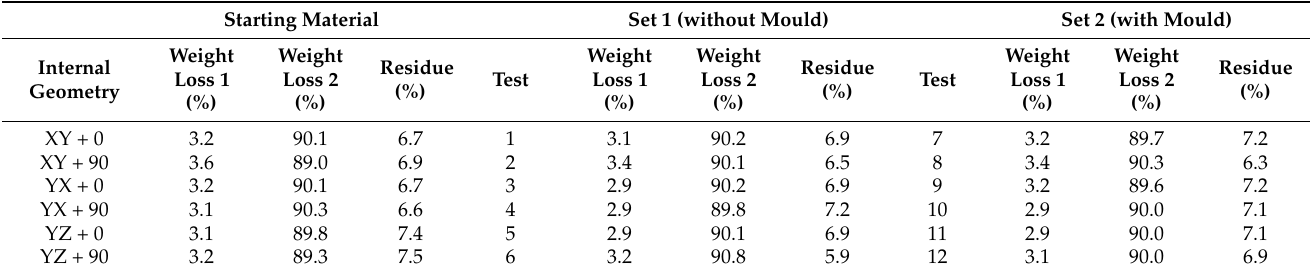
Table 11. Weight loss and residue